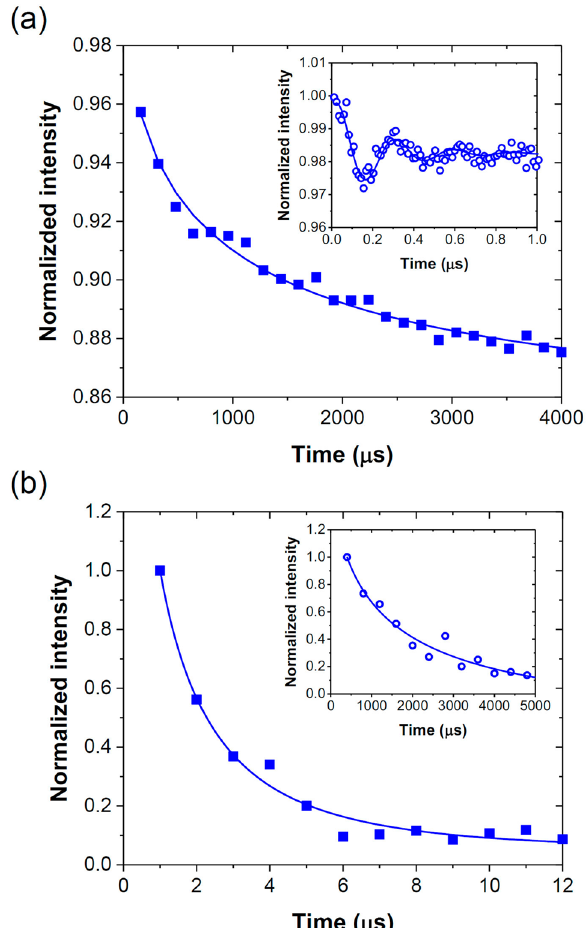
Figure 5. ( a ) Measurement for the MW-driven relaxation time at 2682 MHz. Inset: Zoom-in relaxation data of the same MW in a 1-μs time window for the measurement of Rabi frequency. ( b ) Measurement for the spin–spin relaxation time with T 2 = 1.7 μs. The times labeled in the x-axes are the durations between pairs of MW π/2 pulses 43 . Inset: Measurement for the spin–lattice relaxation time with T 1 = 1491 μs. The times labeled in the x -axes are the durations between MW π and optical readout pulses 27 . Solid curves are best fits of the experimental